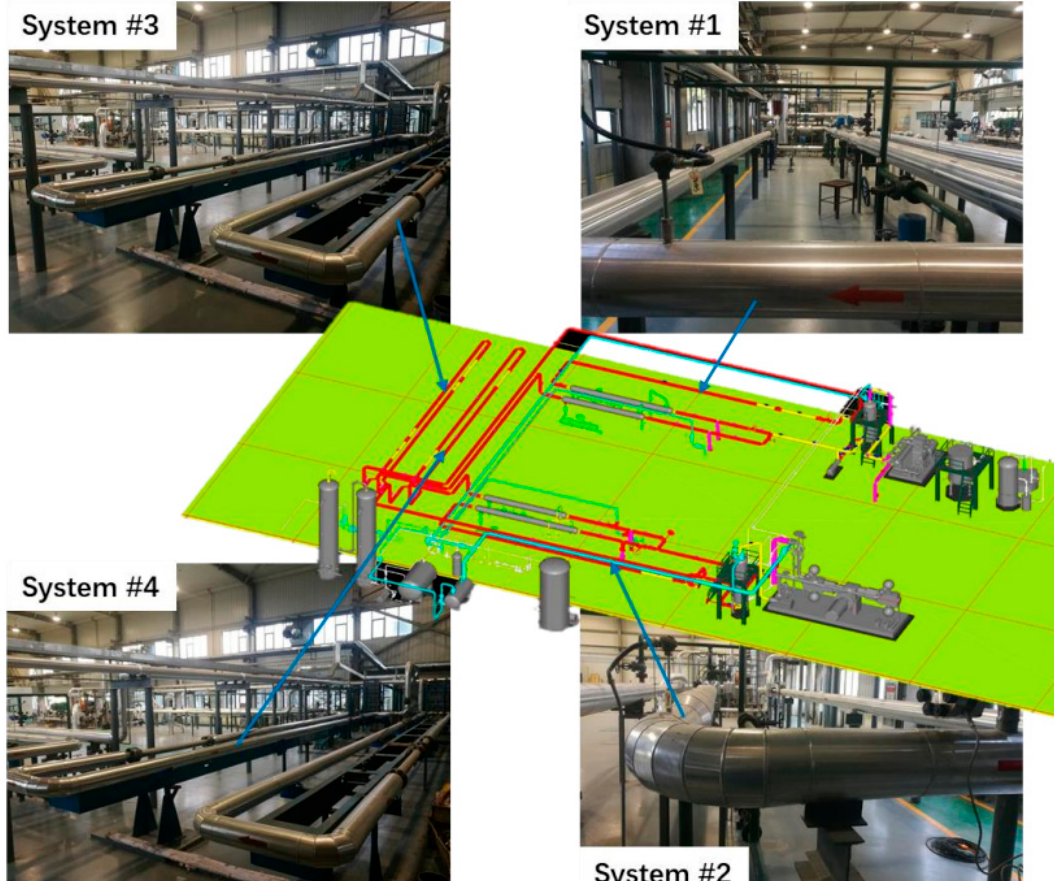
Figure 1. Schematic of the multiphase flow corrosion simulation loop test device. Figure 1. The System #2 flow loop is a 4 − inch − diameter, high − temperature, high −